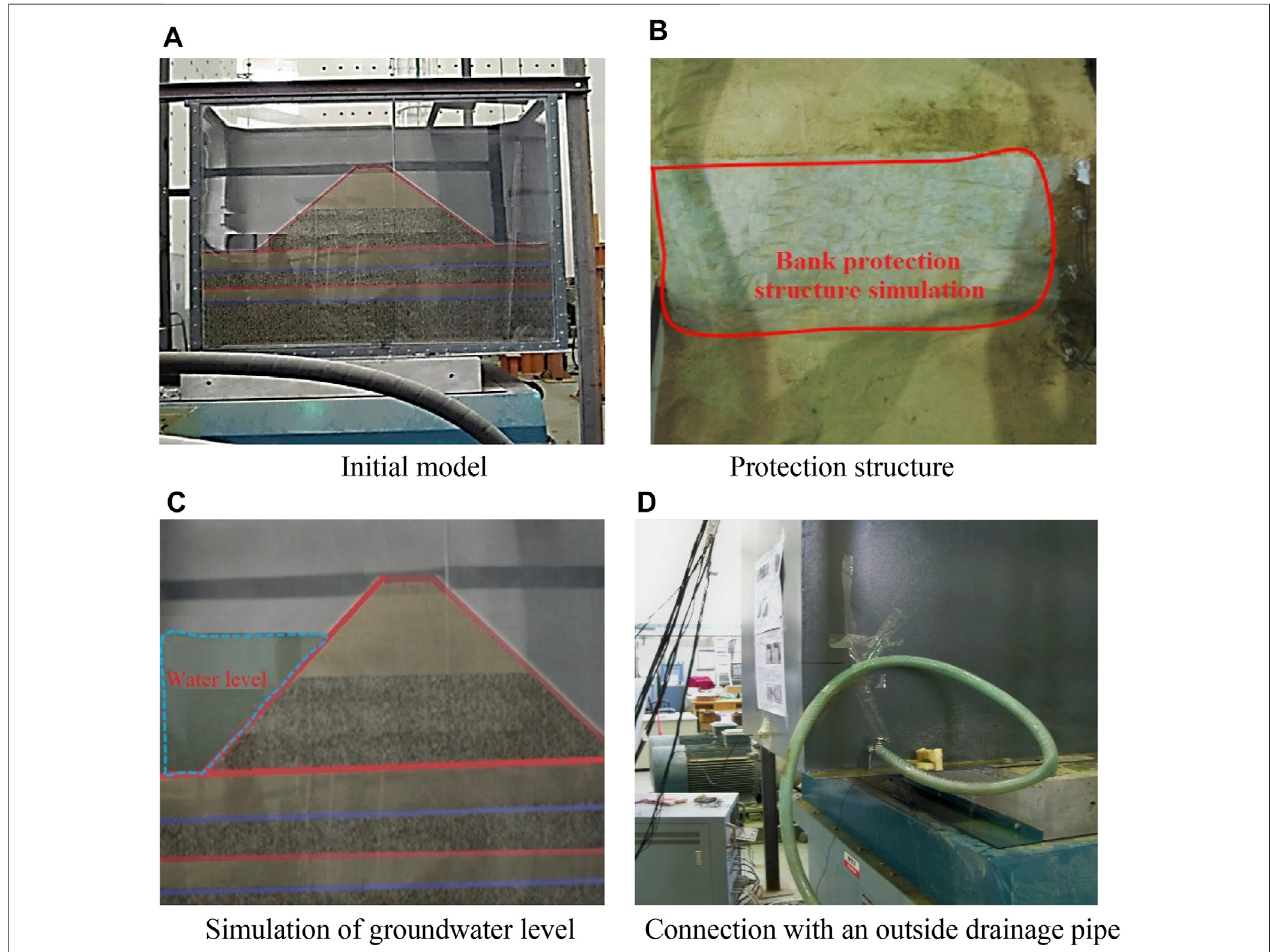
FIGURE 14 | Test model of the slope. (A) Initial model. (B) Protection structure. (C) Simulation of the groundwater level. (D) Connection with an outside drainage pipe.